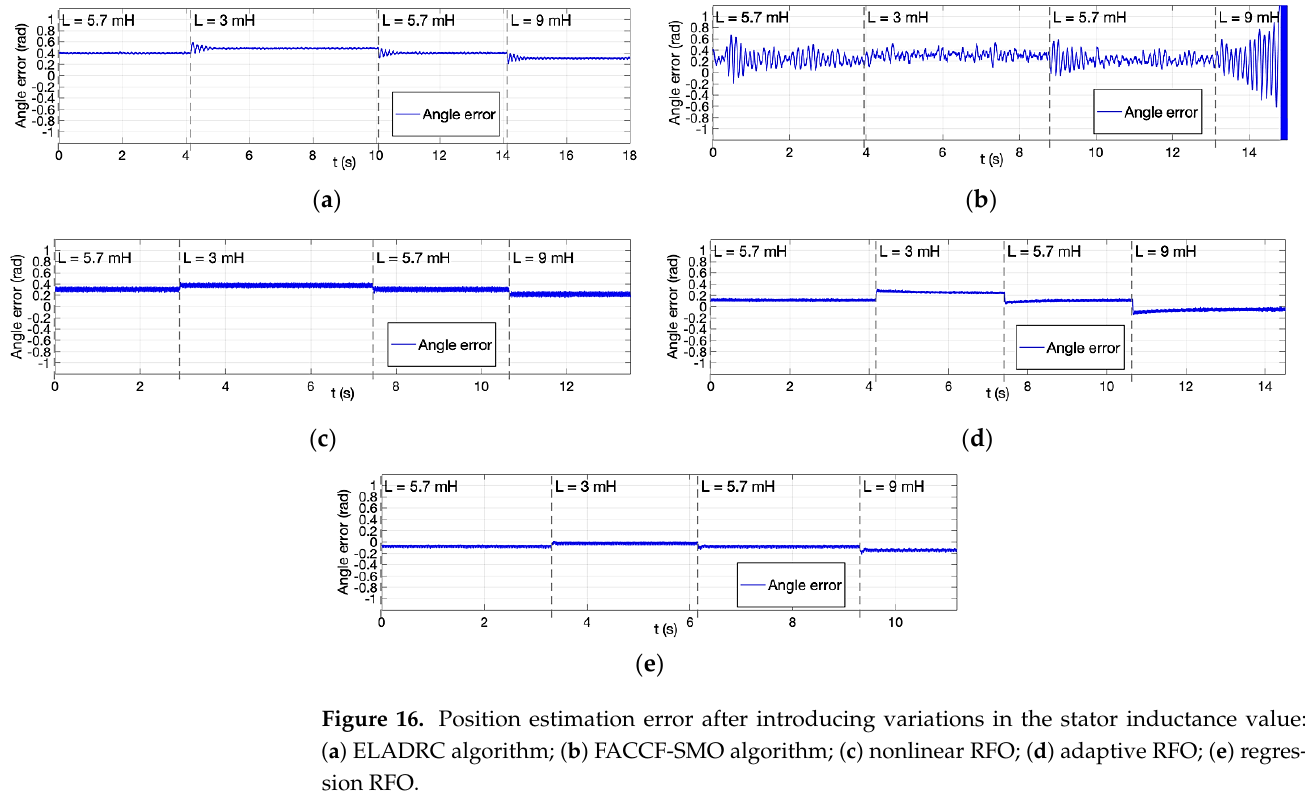
( d ) ( e ) Figure 15. Reference, estimated and measured speed during starting with full load applied: ( a ) ELADRC algorithm; ( b ) FACCF-SMO algorithm; ( c ) nonlinear RFO; ( d ) adaptive RFO; ( e ) regression RFO.